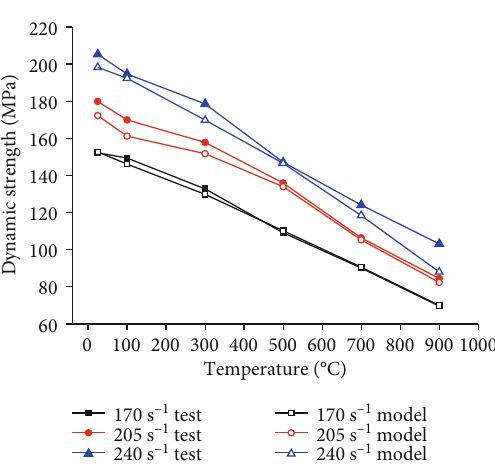
Figure 9: The comparison between theoretical and test dynamic strengths of deep sandstone